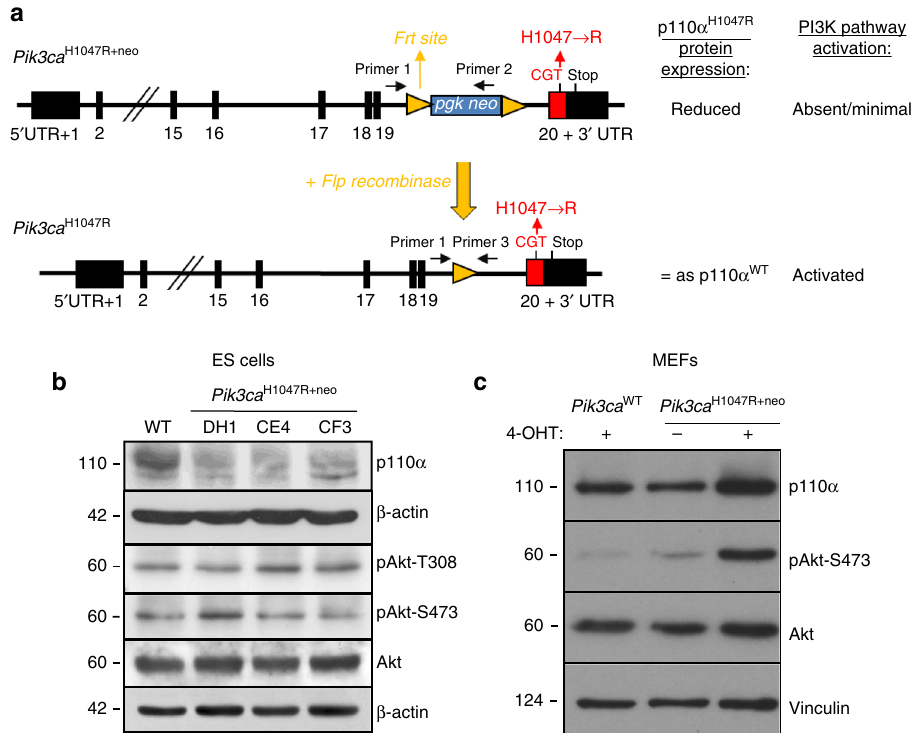
Fig. 1 Gene targeting to create a hypomorph Pik3ca H1047R+neo allele. a Targeted Pik3ca allele showing the frt - fl anked neo selection cassette, before and after Flp-mediated recombination. Exon sequences are represented by fi lled black rectangles, intron sequences by a black line. The frt sites are represented as yellow triangles with the pointed end indicating orientation. The positions of the primers used for PCR screening are designated by arrows. b p110 α expression levels and phosphorylation of Akt in Pik3ca WT and Pik3ca H1047R+neo ES cells. c p110 α expression and Akt phosphorylation in Pik3ca WT ; Flpe-ER T2 and Pik3ca H1047R+neo ; Flpe-ER T2 MEFs, 72 h after addition of 4-OHT or